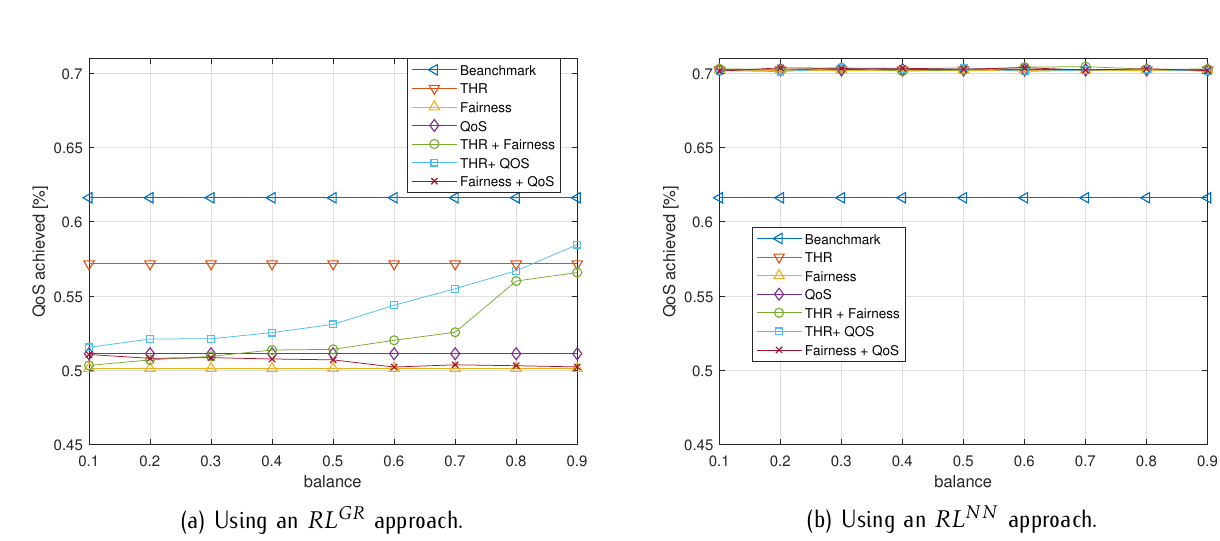
Figure 4. Percentage of downlink throughput respect to the T HR